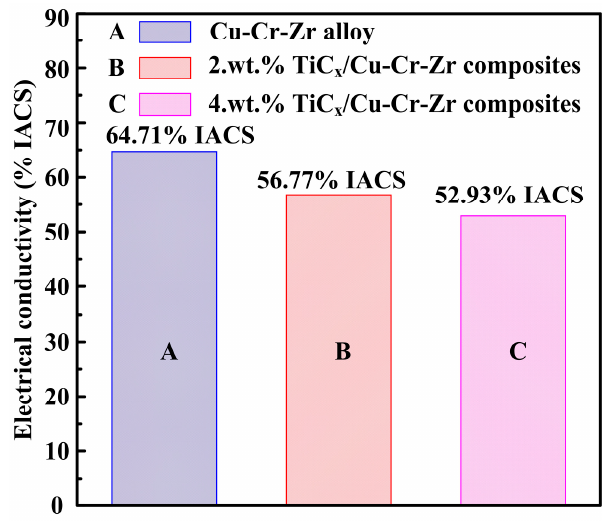
Figure 8. The electrical conductivity of Cu–Cr–Zr alloys and TiCp-reinforced Cu–Cr–Zr